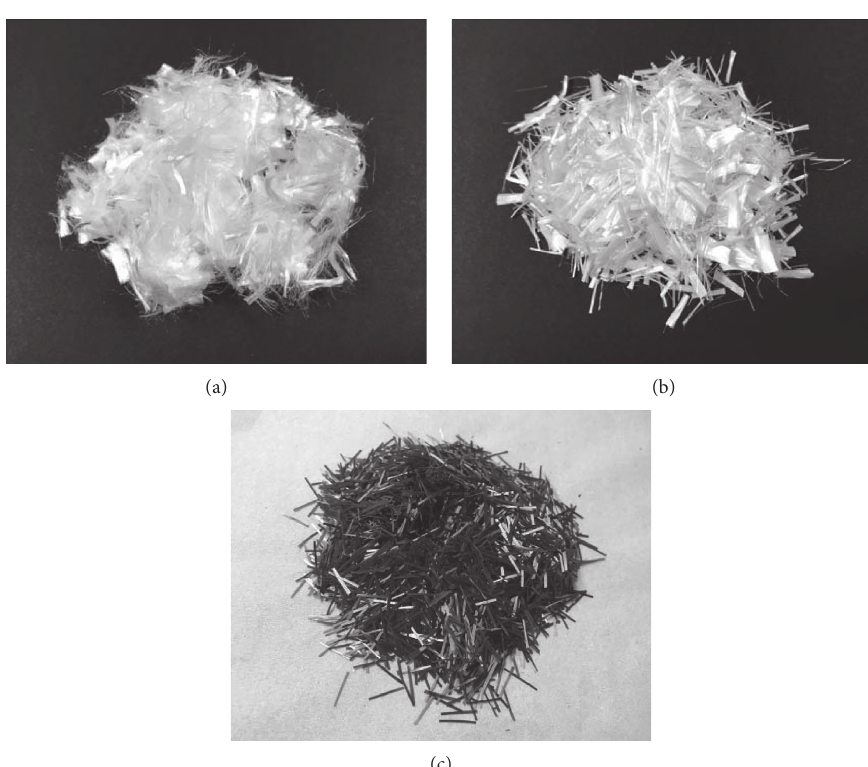
Figure 2: (a) PP fibres; (b) PVA fibres; (c) basalt